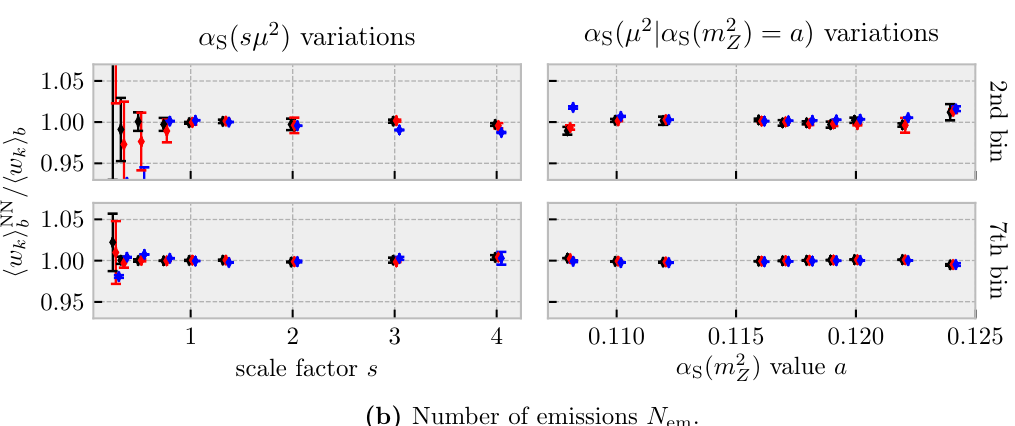
Figure 8 . Ratios between neural-net-predicted and true reweighting factors for a low- and a high- t lead ( N em ) bin are shown in the upper (lower) two rows, using N in = 60 (black), 40 (red) and 5 (blue) input neurons. The hidden layer of ReLU is in each case set to have N in = 4 neurons (rounding down to the next